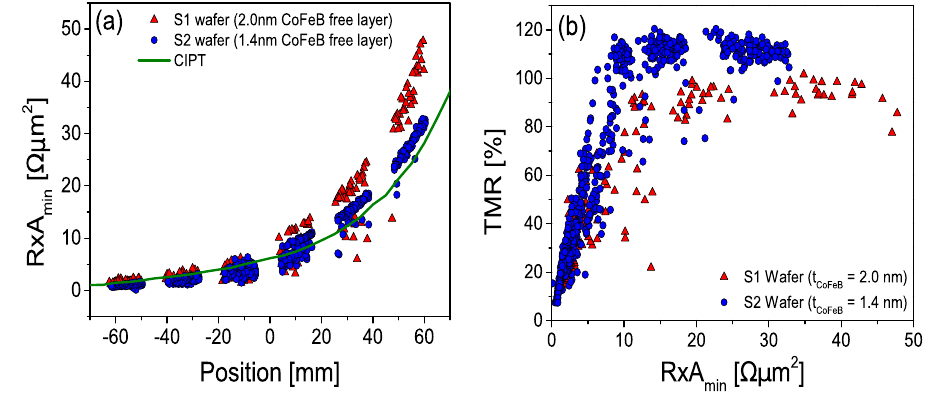
Figure 1. DC electrical characterization. R × A and TMR values extracted from the measured transfer curves in a 4-point contact geometry (red triangles correspond to S1 with t CoFeB = 2.0 nm and the blue circles to S2 with t CoFeB = 1.4 nm). ( a ) R × A of the measured MTJs and CIPT (of sample S1) measurements along the wafer position (green line) ( b ) TMR vs. R × A measured for the full collection of 200 nm MTJ